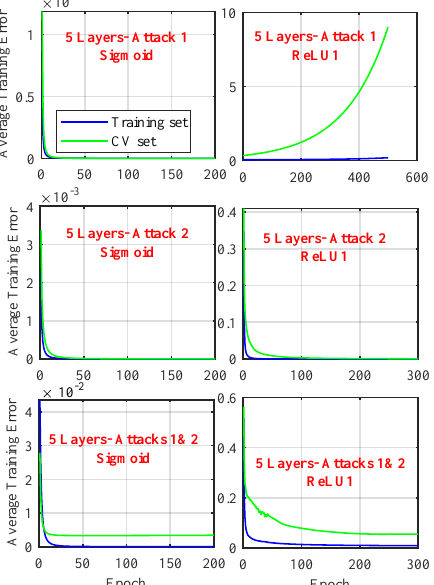
Figure 4. Average of training and cross validation errors for a 5-layer DNN are demonstrated. The left column represents the results associated with using sigmoid for the first and the second hidden layers and softmax for the third hidden layer, while the right column shows the results of using ReLU in the first hidden layer, sigmoid in the second layer, and softmax in the third hidden layer. From the top, the top row subplots refer to the detection algorithm against attack 1, the middle row is associated with attack 2, and the bottom row explains detection of simultaneous attacks 1 and